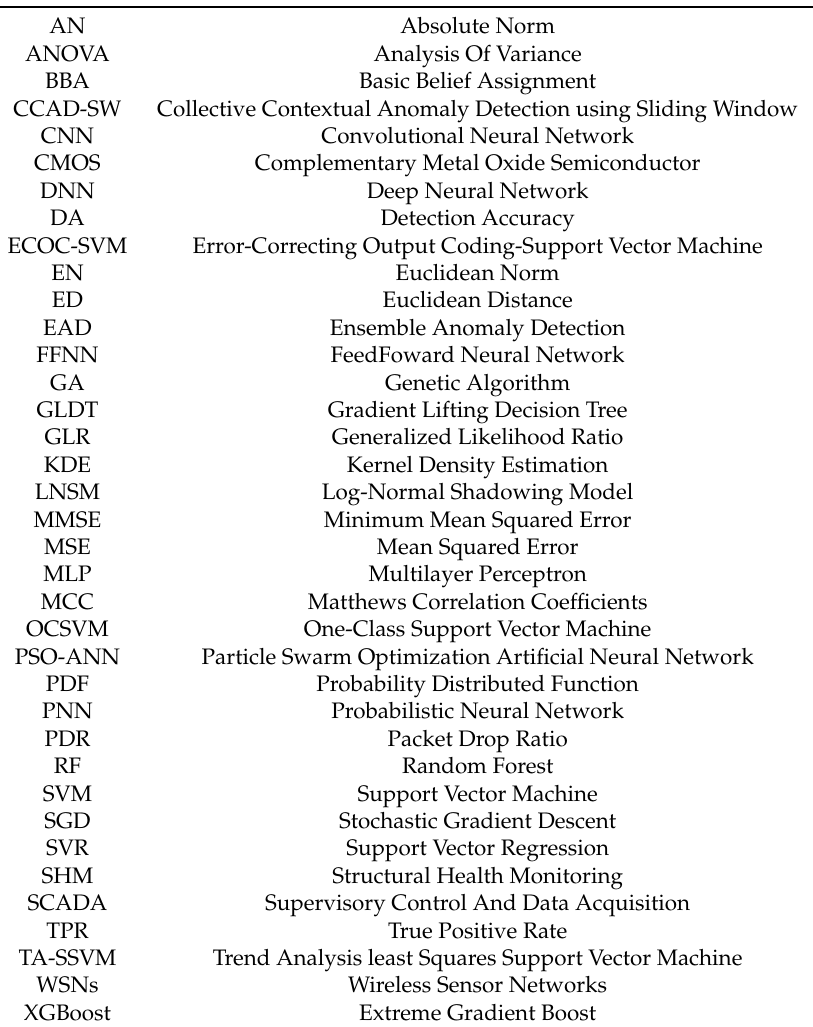
Table 1. List of